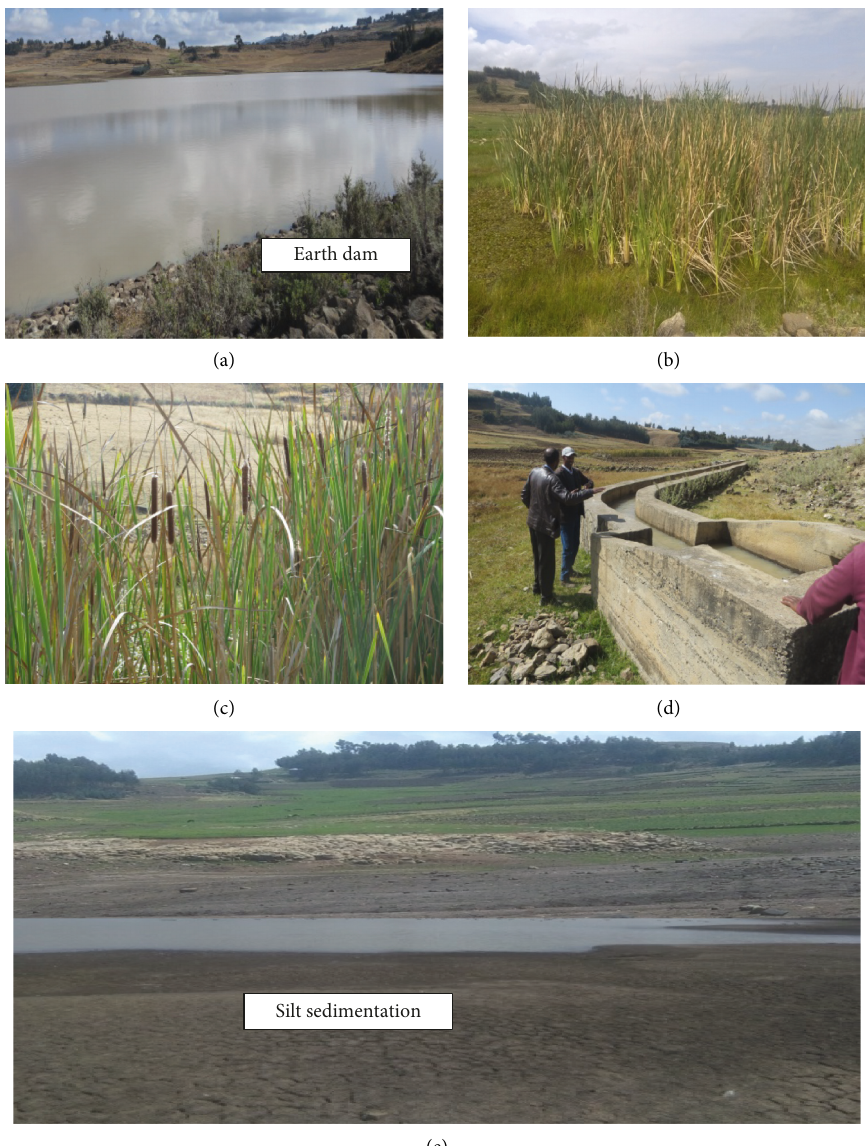
Figure 4: Partial views of Borale sites during the wet (a, b) and dry (c, d, e) seasons, with its reservoir and Earth dam (a), downstream wetlands covered with Typha, Cyperus, and Commelina species (b–c) and the canal (d), silt sedimentation, highly reduced water volume, catchment ploughed and covered with barely growing during a light rainy season (locally called ‘Belg’) from February to April and some woodlots of Eucalyptus globules nearby corrugated iron homes (e) (Photos taken from September 2020 to May 2021). Table 6: The factors and their values, total HDGSs, and ecological status of the artificial wetlands. Wetlands Factor 1 Factor 2 Factor 3 Factor 4 Factor 5 Factor 6 Total HDGS Wetland status Washa 12 MI Borale